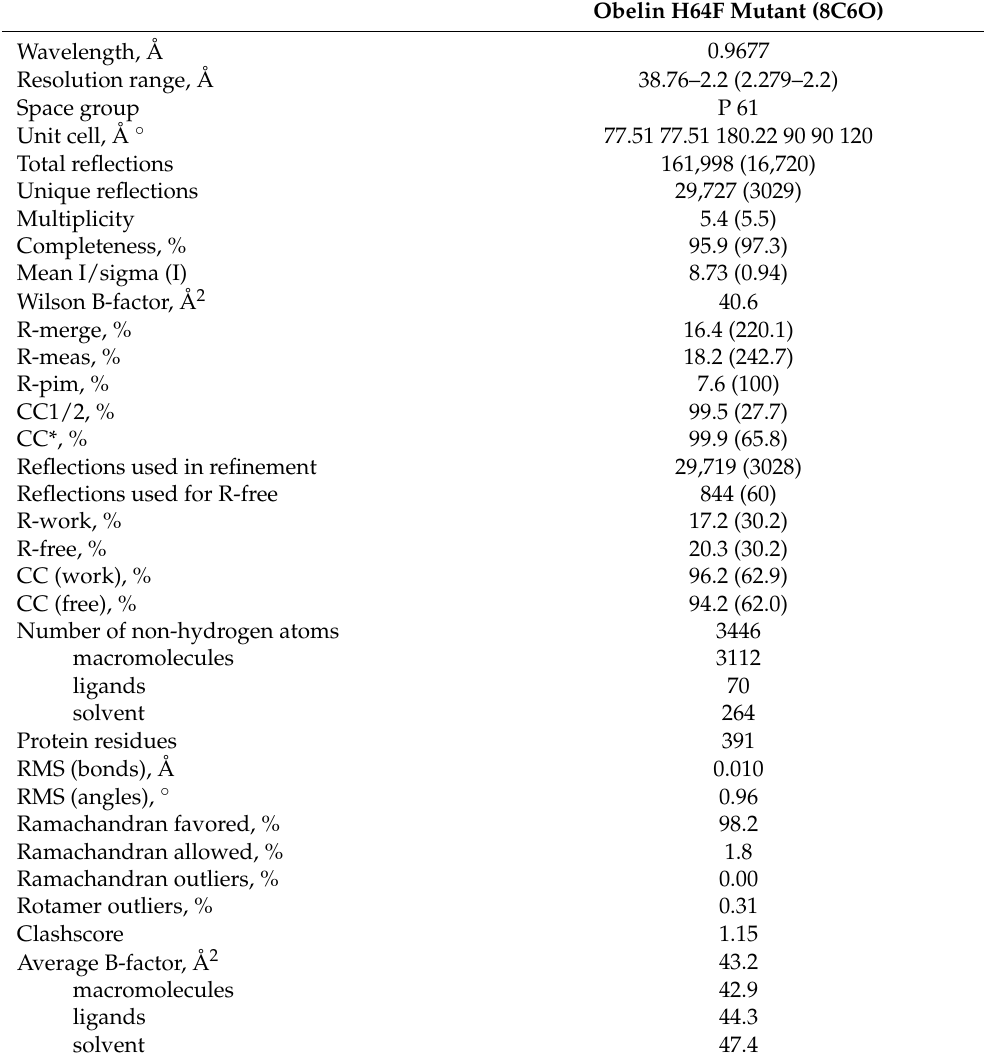
Data collection and refinement